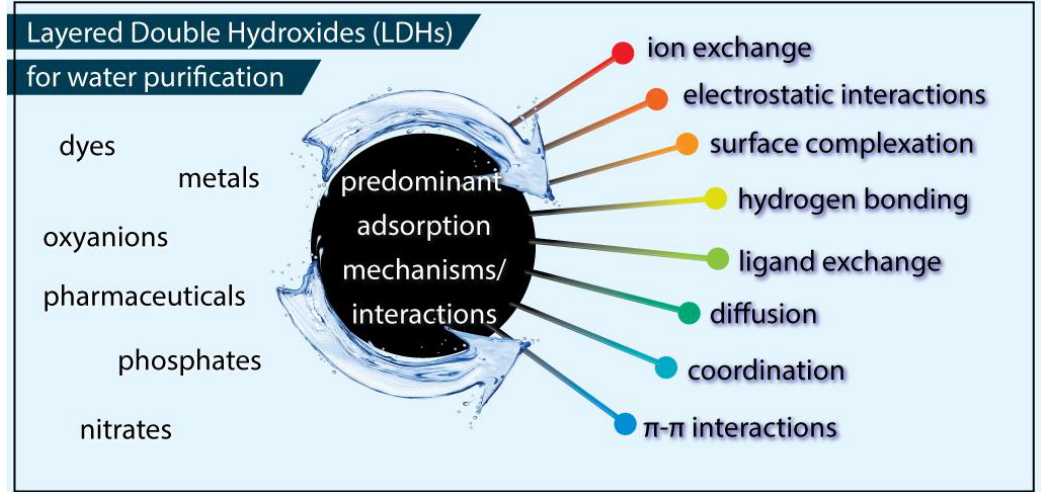
Figure 1. All the reported interactions/mechanisms involved in the removal of various pollutants by Layered Double Hydroxides (LDHs).